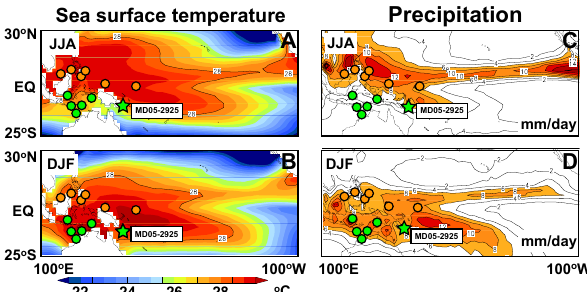
Table 1. AMS 14 C dates of site MD05-2925.